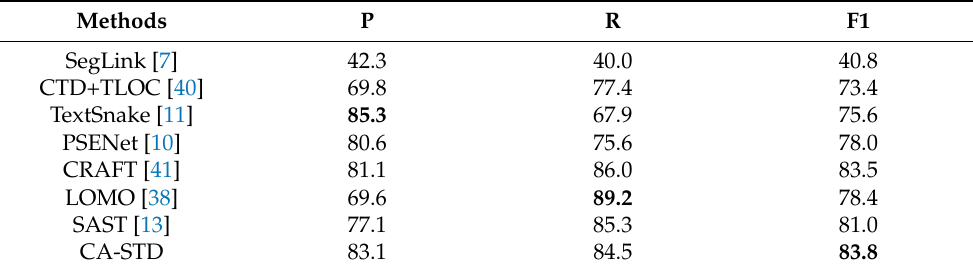
Table 2. The results on